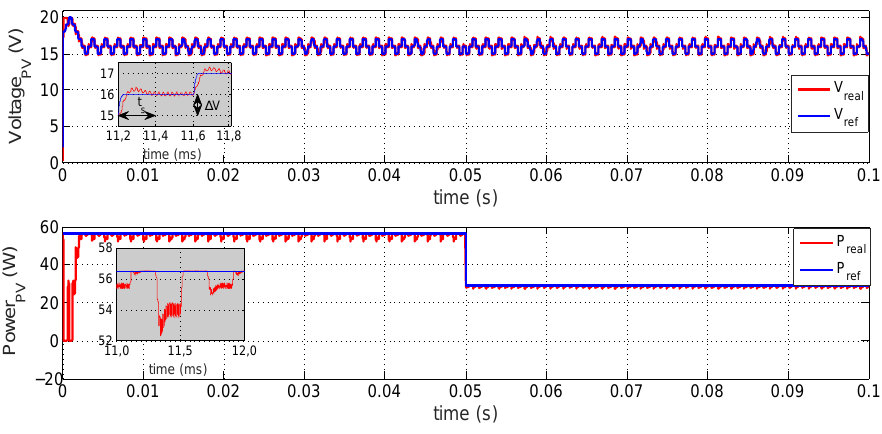
Figure 7. MPPT based on P& O. Profile of the PV panel voltage and power extraction.